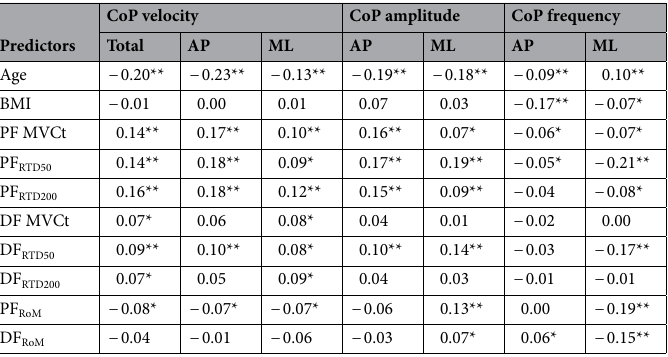
Table 3. Correlation matrix of Pearson’s r for body sway variables and predictors (N = 633). *Significant at p < 0.05. **Significant at p <